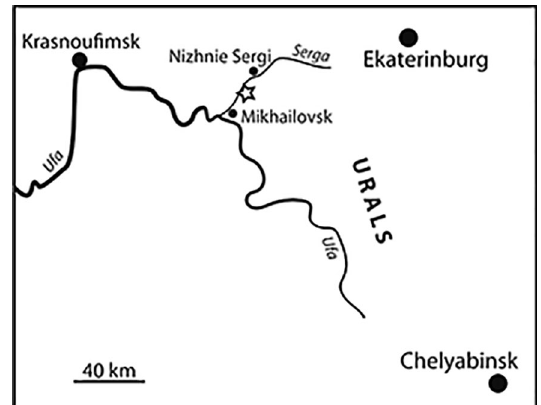
Fig. 1. Map of the